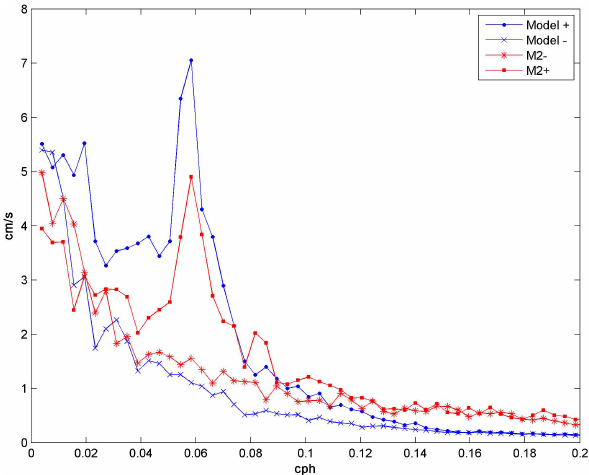
Fig. 19. Time series of daily mean wind stress magnitude and ver- tical velocities standard